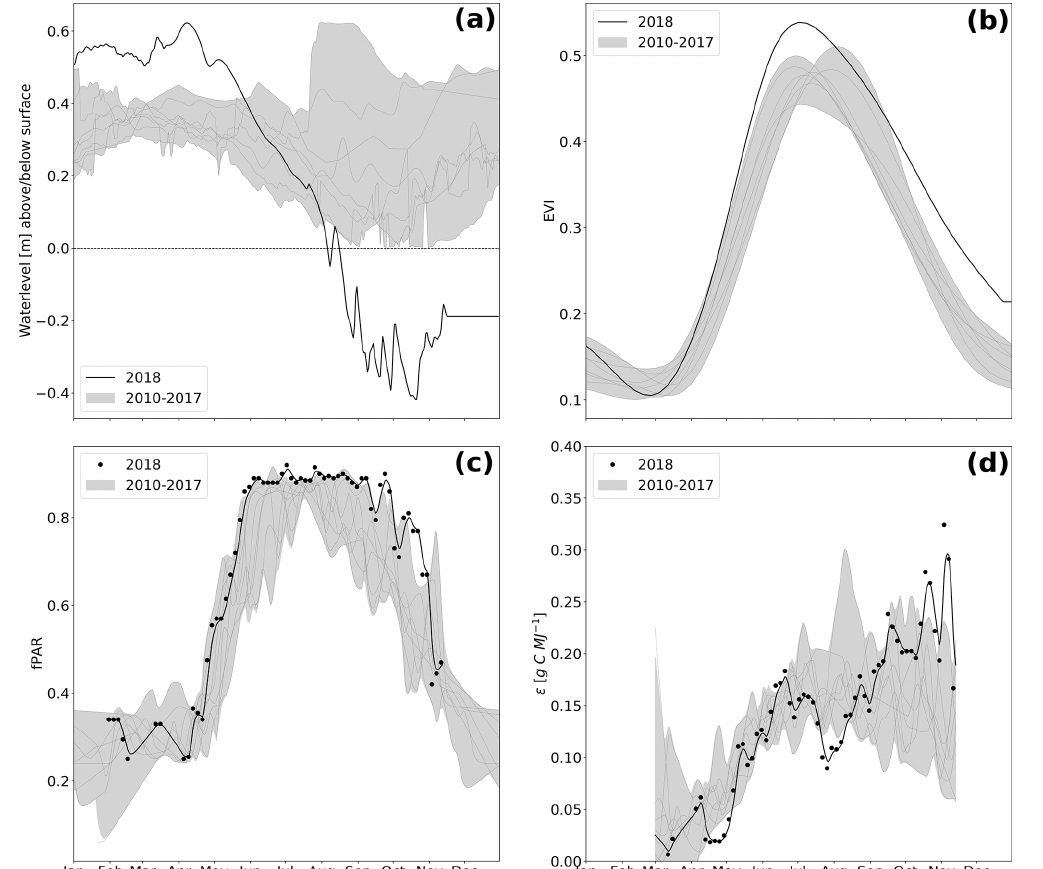
Figure 3. Water level (a) , enhanced vegetation index (EVI, b ), absorbed photosynthetically active radiation (fPAR, c ), and light use efficiency ( (cid:15) , d ) over the course of the year. Values measured in 2018 are represented as black lines, whereas the grey shading represents the value range (minimum–maximum) throughout the reference period 2010–2017. Due to large uncertainties occurring during the dormancy period, (cid:15) is presented only for the growing season.